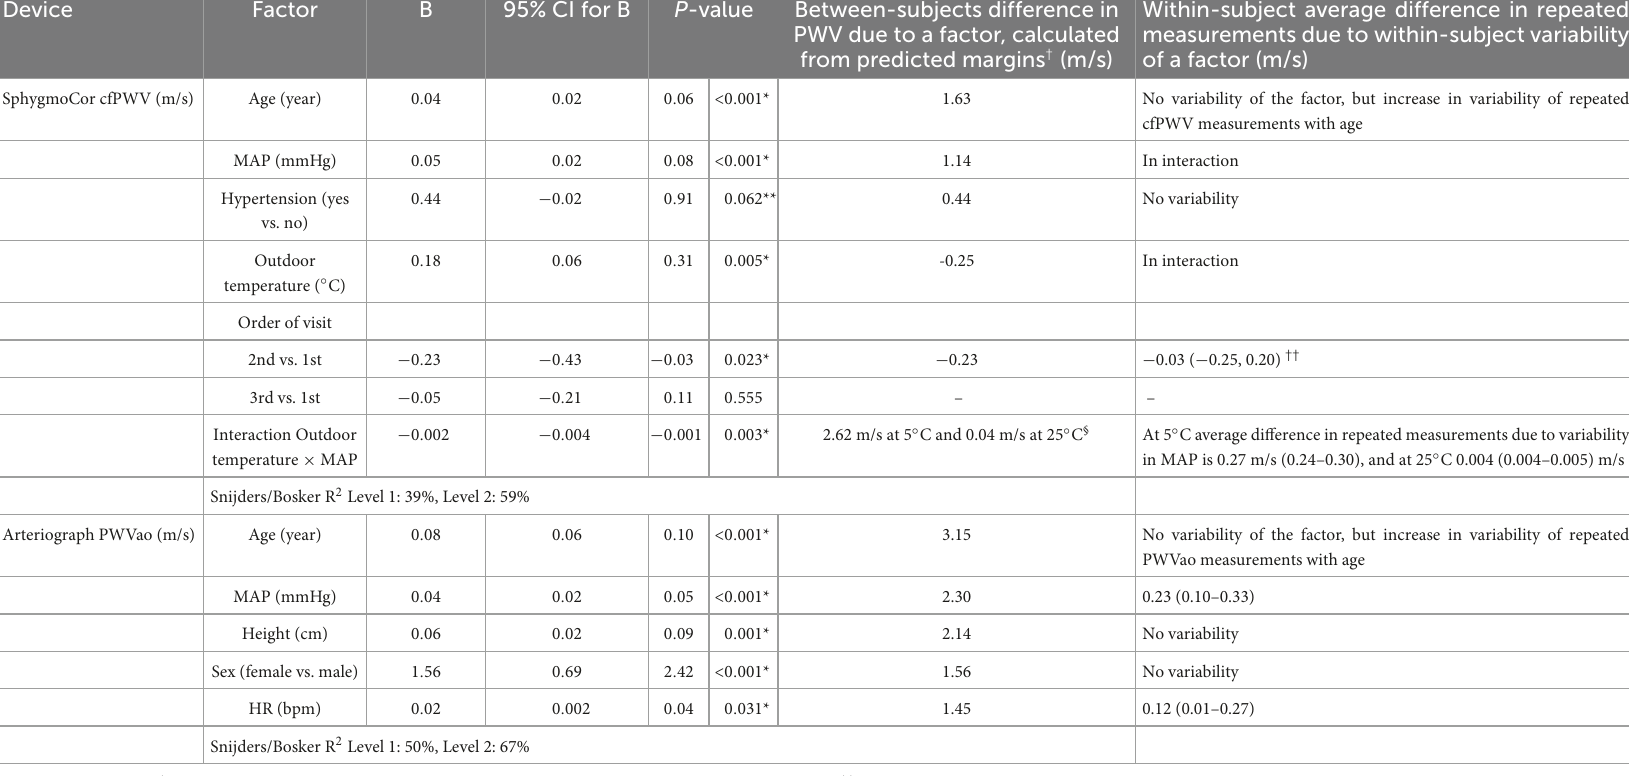
B, regression coefficient. † Difference in predictive margins of PWV for an observed range of a factor, adjusted for other factors. †† Values in the brackets are calculated considering uncertainty of estimates for regression coefficient and factors’ within- subjectvariability. § FortheinteractiontermwecalculatedthemaximalexpectedchangesincfPWVgiventheMAPrange:at5and25 ◦